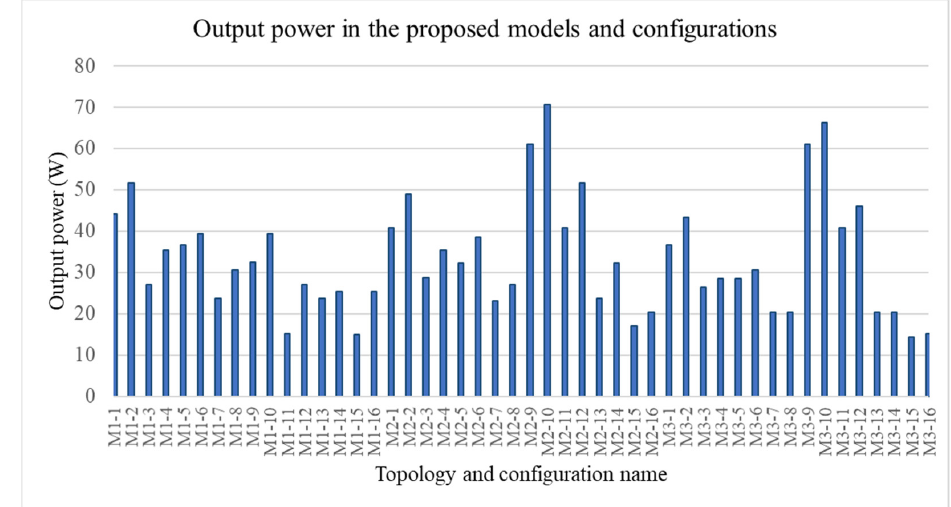
Figure 9. The output power of different topologies and configurations.